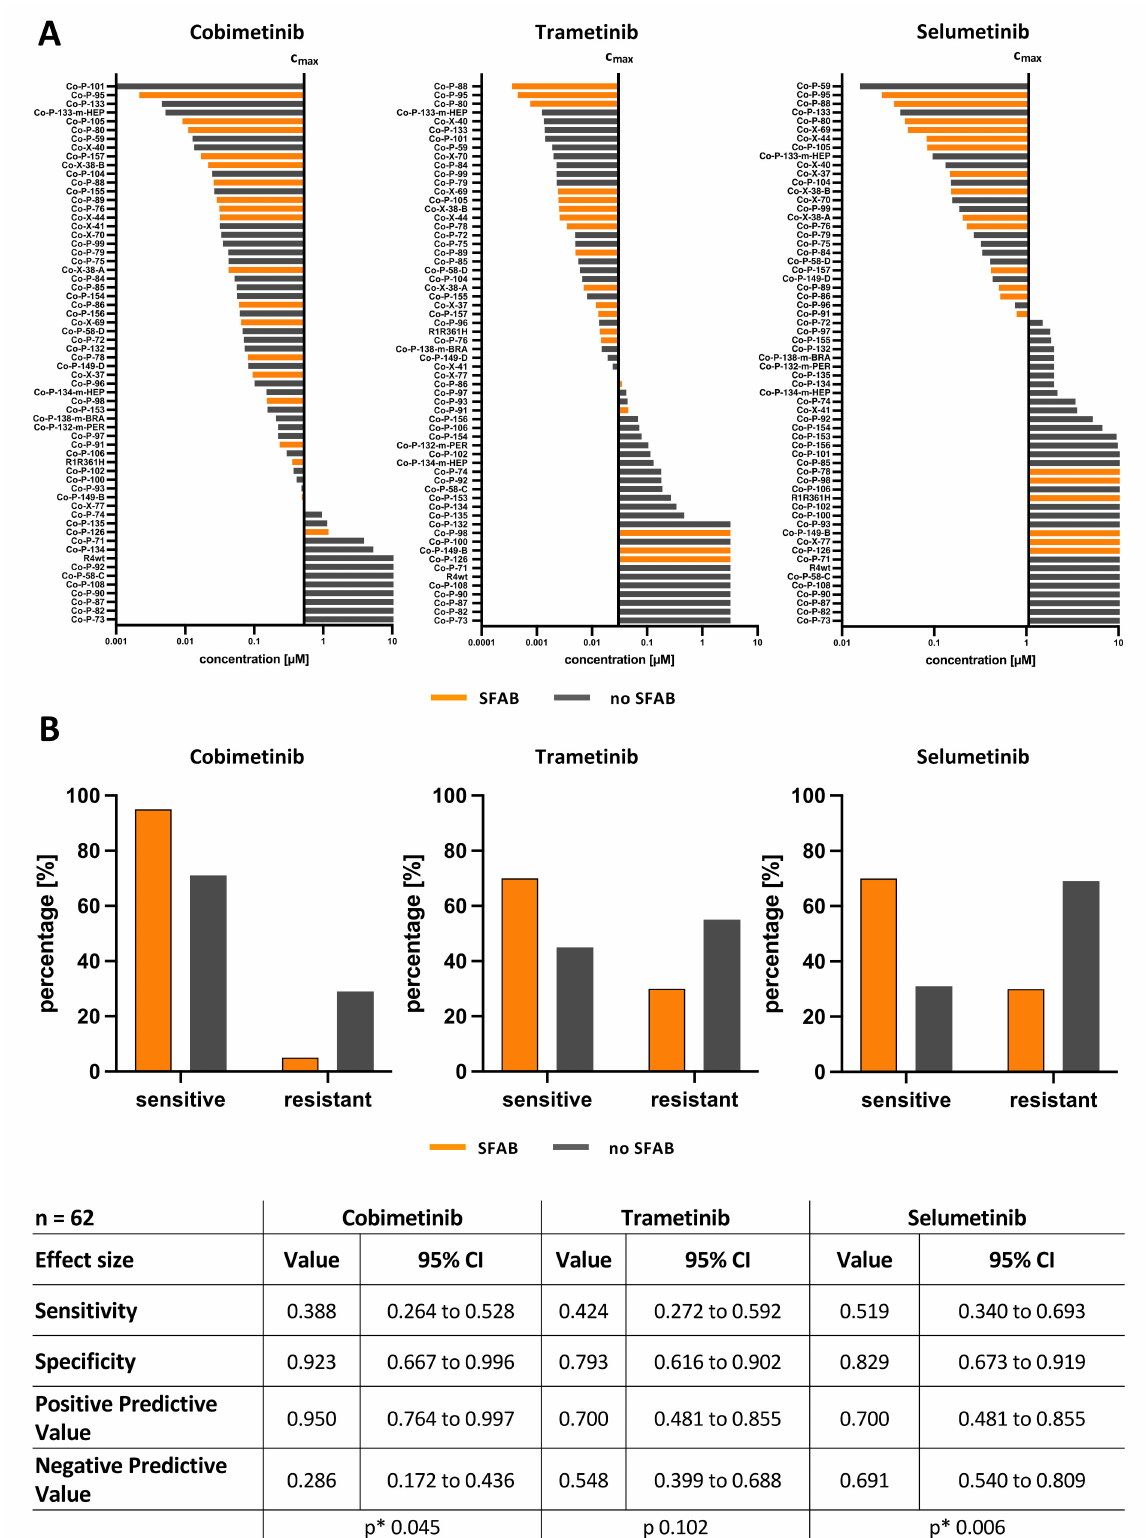
Figure 5. CRC PDO models with SFAB- ( SMAD4 , FBXW7 , ARID1A , or BMPR2 ) signature are sensitive to MEK inhibition . ( A ) Waterfall plots of IC 50 values of CRC PDO models with known SMAD4 status tested with MEK-inhibitors cobimetinib, trametinib, and selumetinib. PDO models with IC 50 values below c max are defined as sensitive and PDO models with IC 50 values above c